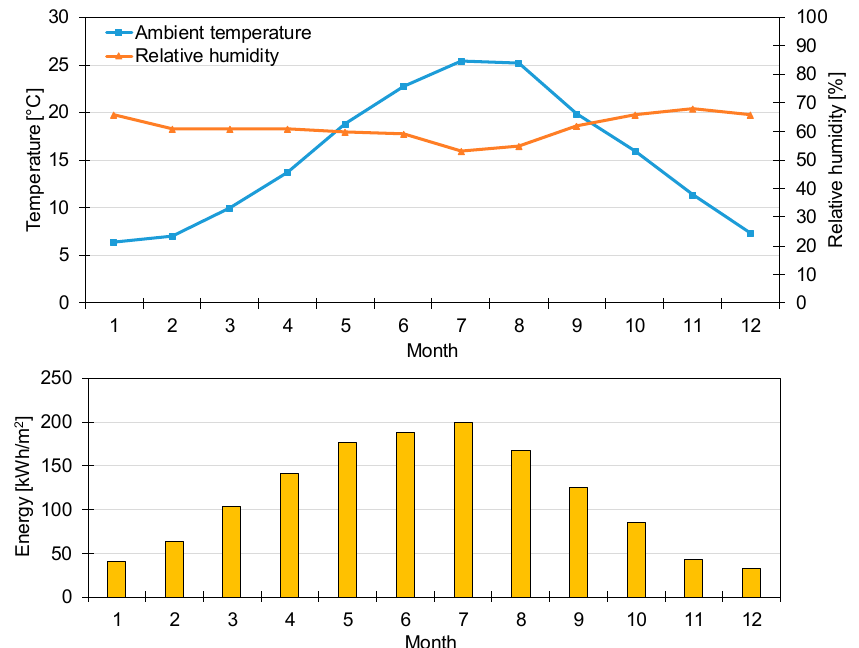
Figure 2. Annual variation of mean monthly ambient temperature and mean monthly relative humidity ( upper ); annual variation of monthly solar radiation on a horizontal surface ( lower ).